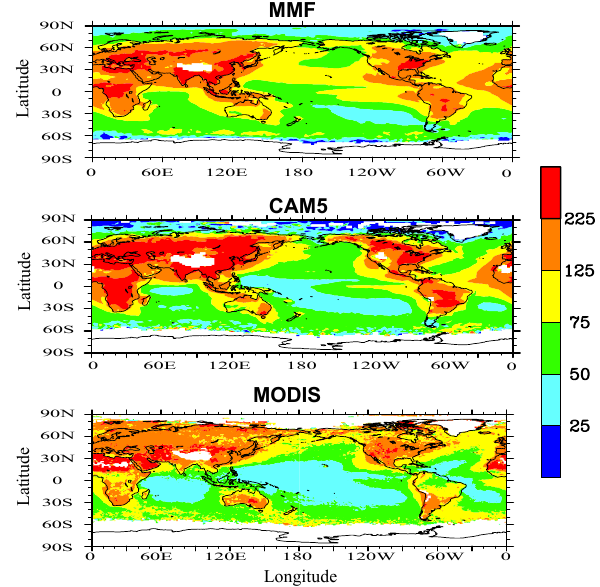
Figure 06 Fig. 6. PD annual-averaged cloud-top droplet number concentra- tions (cm − 3 ) derived from the MMF (upper panel), CAM5 (middle panel) and MODIS (lower